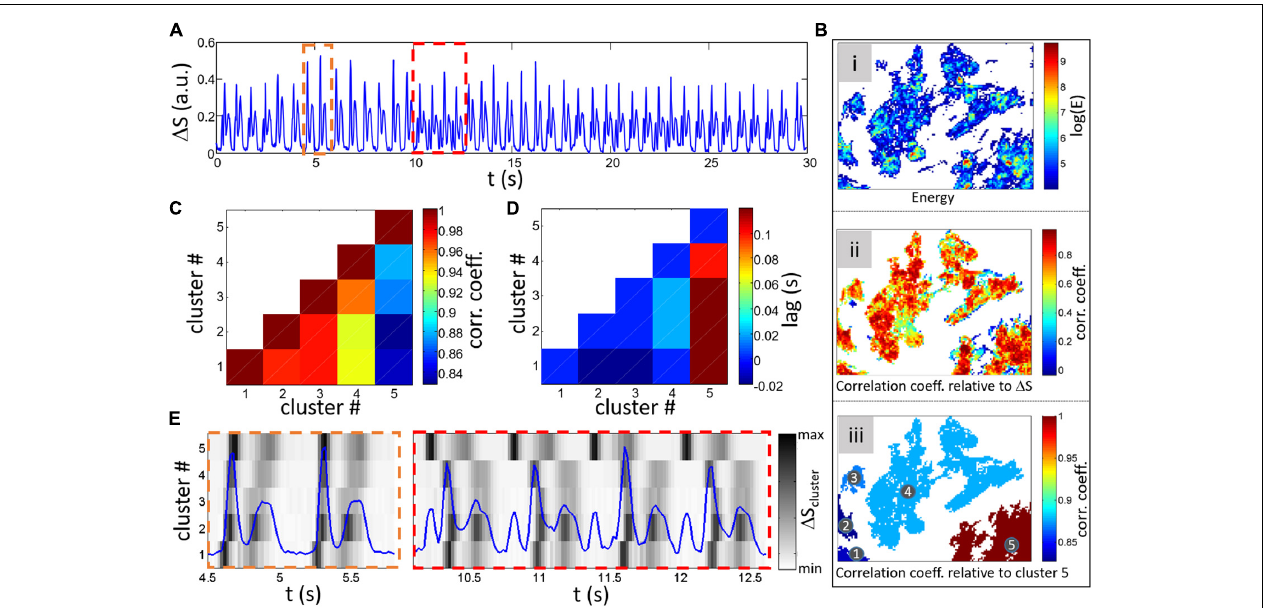
FIGURE 10 | Analysis of a different global (cid:49) S for a different sample with complex activity. (A) Example of a non-stationary global signal with time intervals where multiple peaks (different to the contraction/relaxation peaks usually found). Two intervals are highlighted by dashed rectangles with the orange one showing the normal double peak signal and the red rectangle with multiple peaks. (Bi) Map of log(E) after thresholding [log(E) > 4]. (Bii) CC between individual cluster signals and global (cid:49) S . (Biii) Labeled separated clusters with colorscale representing the CC between cluster 5 and other clusters. (C) Matrix of CC between clusters (Pillekamp et al., 2012; Lu et al., 2013; Wendel et al., 2013; Zhang et al., 2013; Hazeltine et al., 2014) with diagonal equal to 1 and (D) lag for maximum CC. Minimum CC and maximum lag are found between cluster 5 and all 4 other clusters. (E) Cluster (cid:49) S signals for the 5 within the two intervals highlighted by rectangles in (A) is shown by a grayscale (peaks are darker and lower values whiter). The global (cid:49) S is plotted in blue on top for